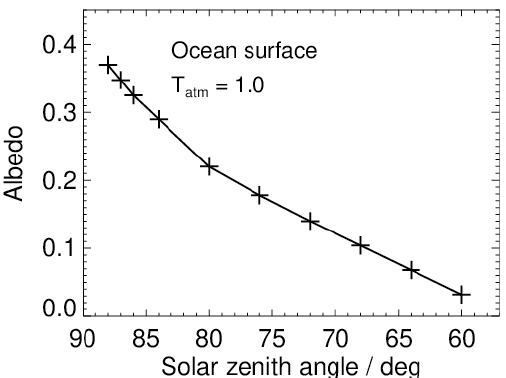
Figure 7. Broadband albedo at the ocean surface as a function of solar zenith angle after Payne (1972) for an atmospheric transmis- sion of τ atm = 1 . 0. These values have been used as input for the radiative transfer